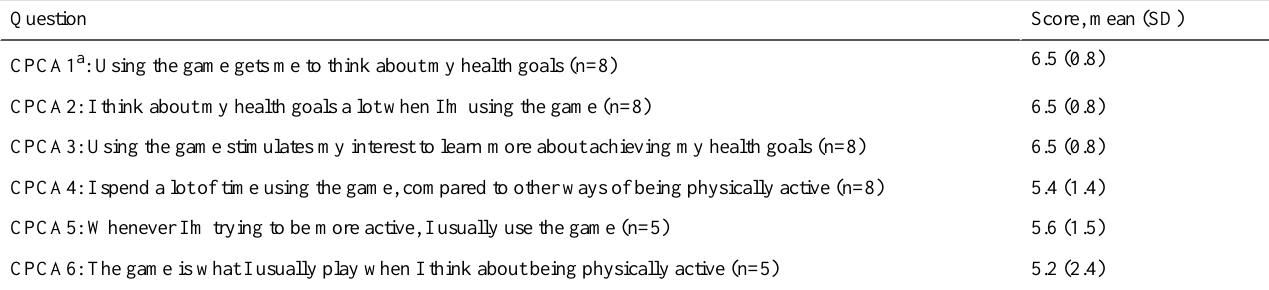
Table 6. Cognitive processing and cognitive engagement individual item